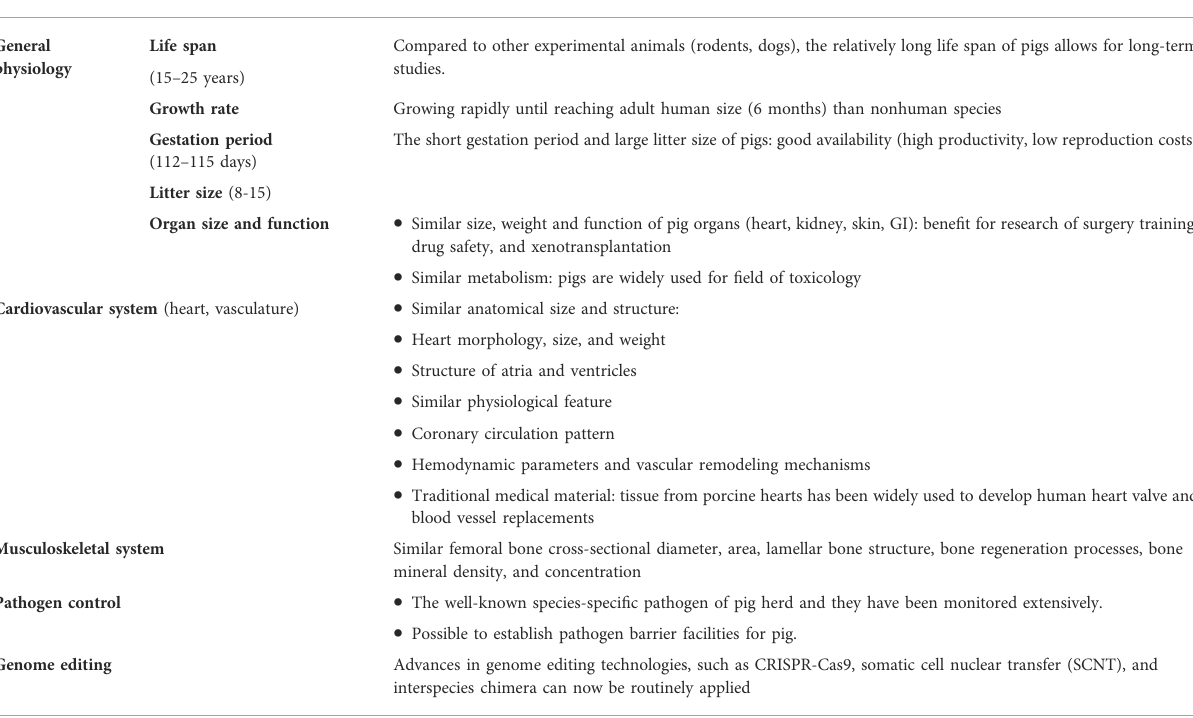
TABLE 3 Characteristics of pigs as a biomedical research